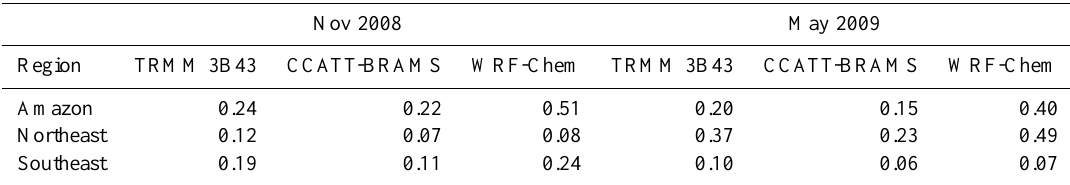
Table 2. Monthly mean precipitation (mmh − 1 ) for TRMM 3B43, CCATT-BRAMS and WRF-Chem models for three regions: the Amazon